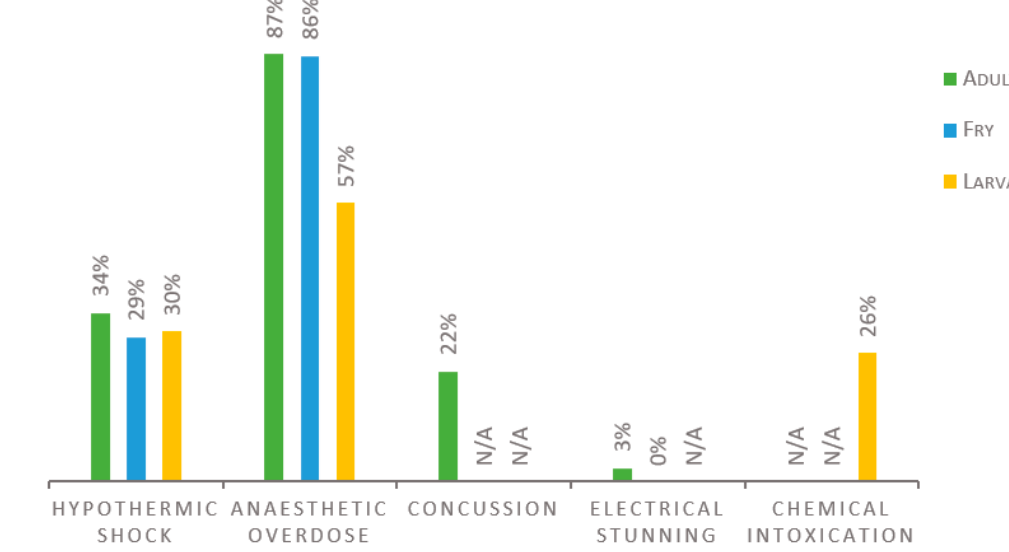
Figure 3. Methods for killing/euthanasia used in fish laboratories according to the developmental stage of the fish, presented as percentage of respondents. Number of respondents was 143, 140, and 138 for adults, fry, and larvae, respectively. Each respondent was allowed to enter multiple answers. N/A; this alternative was not asked for in the survey.